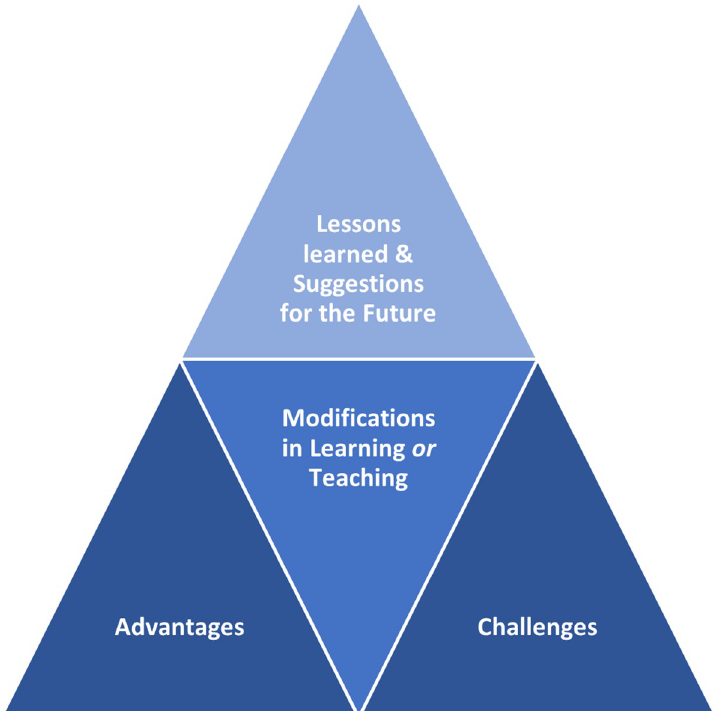
Fig 3. Study’s conceptual framework (illustrating the themes that emerged from the qualitative analyses).